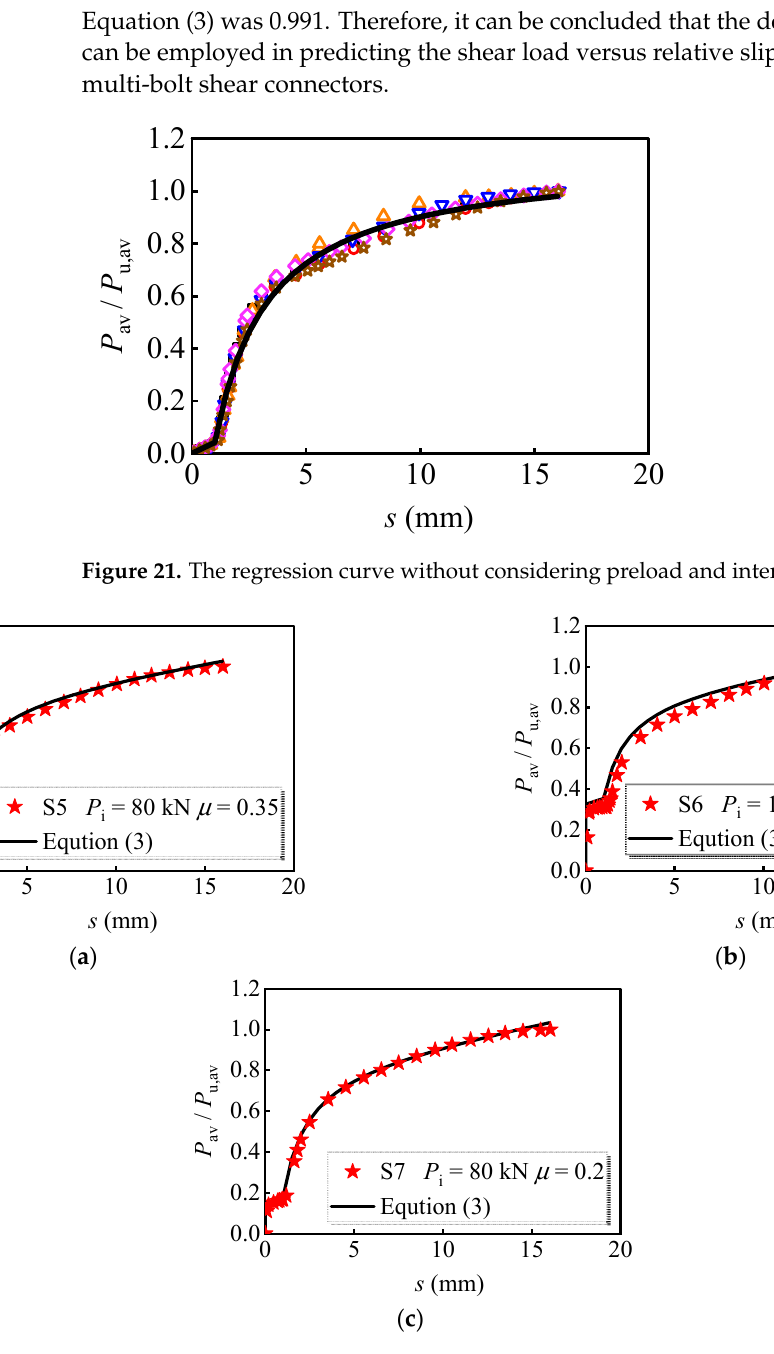
Figure 22. The regression curve considering preload and interface friction: ( a ) S5; ( b ) S6; ( c ) S7.